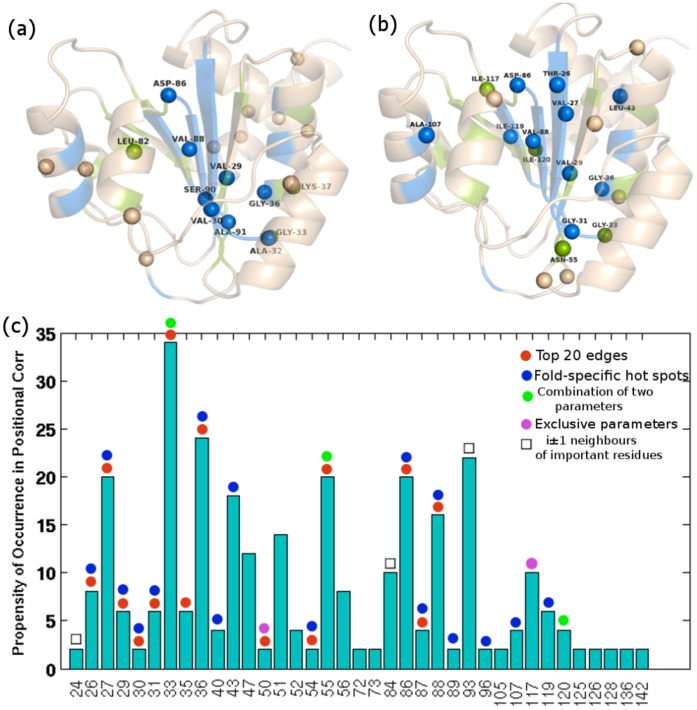
Pictorial depiction of the ‘sector’ residues on the 3D structure glutamyl-trna reductase (1GPJ).(a) ‘Sectors’ obtained from SCA on the MSA of 2373 non-homologous sequences. Out of the 23 ‘sector’ residues, 7 are also identified as important from different combinations of the four network parameters. (b) ‘Sectors’ obtained from SCA on the MUSTANG structural alignment of 84 structures. Out of the 20 ‘sector’ residues, 15 are also identified as important from different combinations of the four network parameters. The overlapping residues between SCA and network based analysis are depicted as blue and green spheres respectively and are also labeled. The backbone is shown in transparent cartoon representation with “fold-specific hot spots” colored blue and those appearing to be important from hubs, EB, NB and top edges or any of their binary combinations colored green. (c) Propensity of occurrence of residues in coevolved pairs from SCA on the structural alignment of 84 structures. Overlap of these residues with those forming top 20 fold conserved edges from f-CAM or any combination of the four network parameters are highlighted as colored dots respectively. The red and the blue dot highlights overlap with top 20 conserved edges and ‘fold-specific hot spots’ respectively. Whereas the green signifies overlap with the residues identified as important from a combination of any two network parameters, the pink dot highlights the overlap with those that are identified as important from a single network parameter. The residues overlapping with i±1 neighbors of important residues from network approach are marked with a black square. It is noteworthy that most of the SCA coevolved residues (both from sequence alignment based SCA and structure alignment based SCA) also figure out as important from the four network parameters.